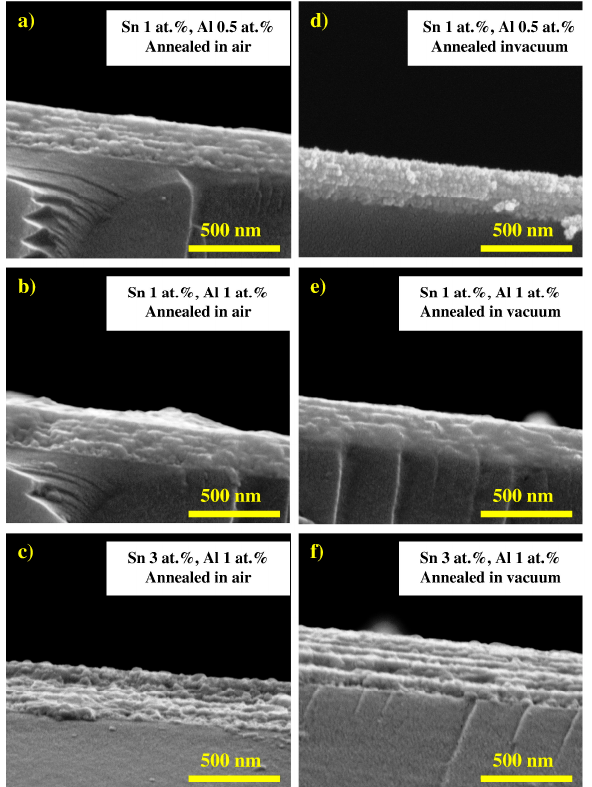
Figure 11. The cross-sectional SEM image of the TAZO thin film, with varying dopant concentrations, annealed at 500 ◦ C for 1 h in air ( a – c ) and vacuum ( d – f ). The doping levels are ( a , d ) Sn = 1 at.% and Al = 0.5 at.%; ( b , e ) Sn = 1 at.% and Al = 1 at.%; and ( c , f ) Sn = 3 at.% and Al = 1 at.%. Reproduced with permission from ref.